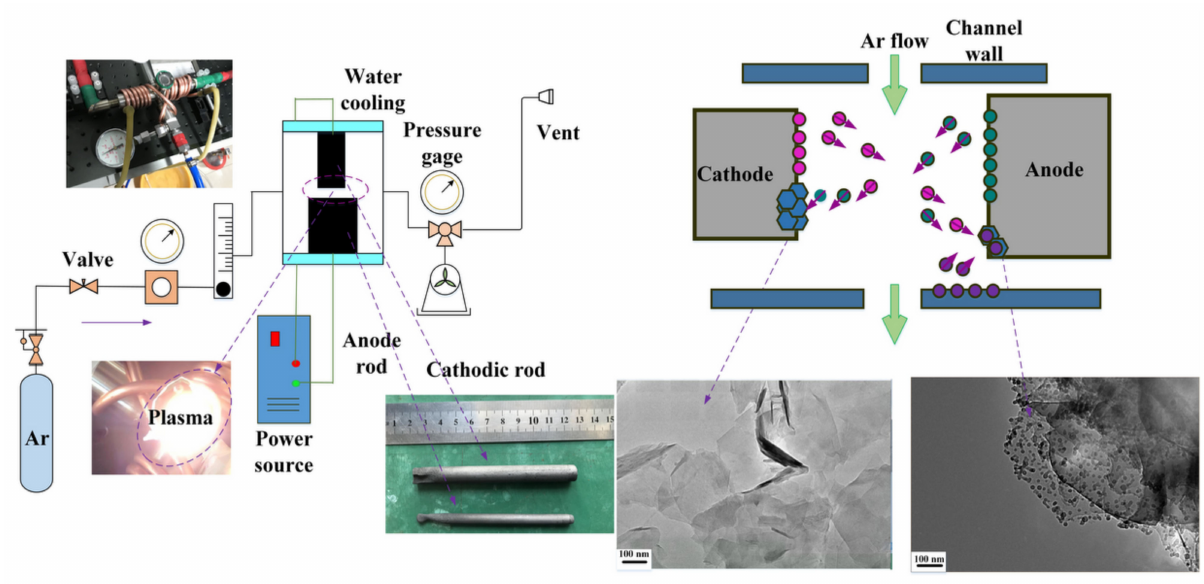
Figure 8. Schematic representation of the arc discharge method for the synthesis of graphene [Reprinted with permission from ref. [71], Tan, H.; Wang, D.; Guo, Y. A Strategy to Synthesize Multi- layer Graphene in Arc-Discharge Plasma in a Semi-Opened Environment. Materials 2019 , 12 , 2279. https://doi.org/10.3390/ma12142279, Copyright ©